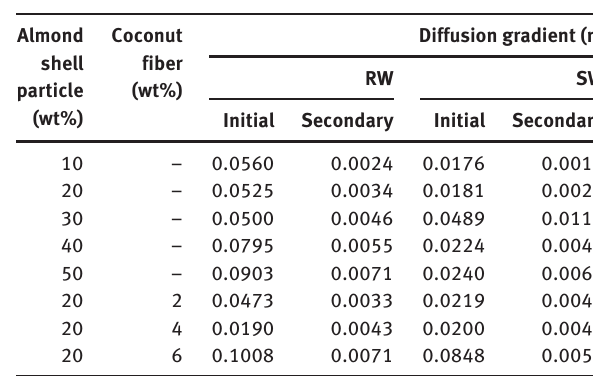
Table 1 Diffusion gradient for different weight percentages of almond shell particles and coconut fibers in RW and SW.